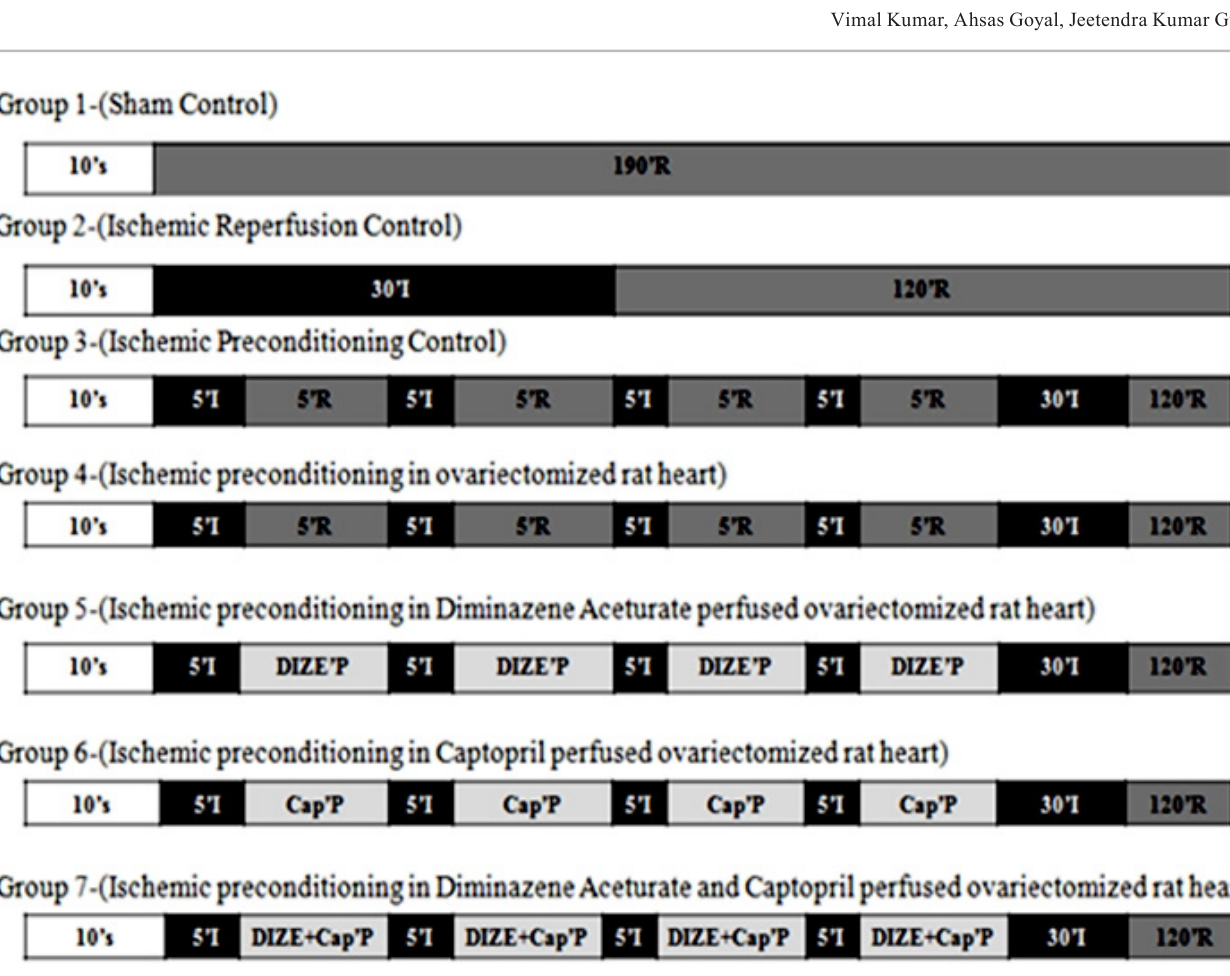
FIGURE 1 - Diagrammatic representation of experimental protocol. S, P, I, R, DIZE, Cap denote stabilization, perfusion, ischemia, reperfusion, diminazene aceturate,